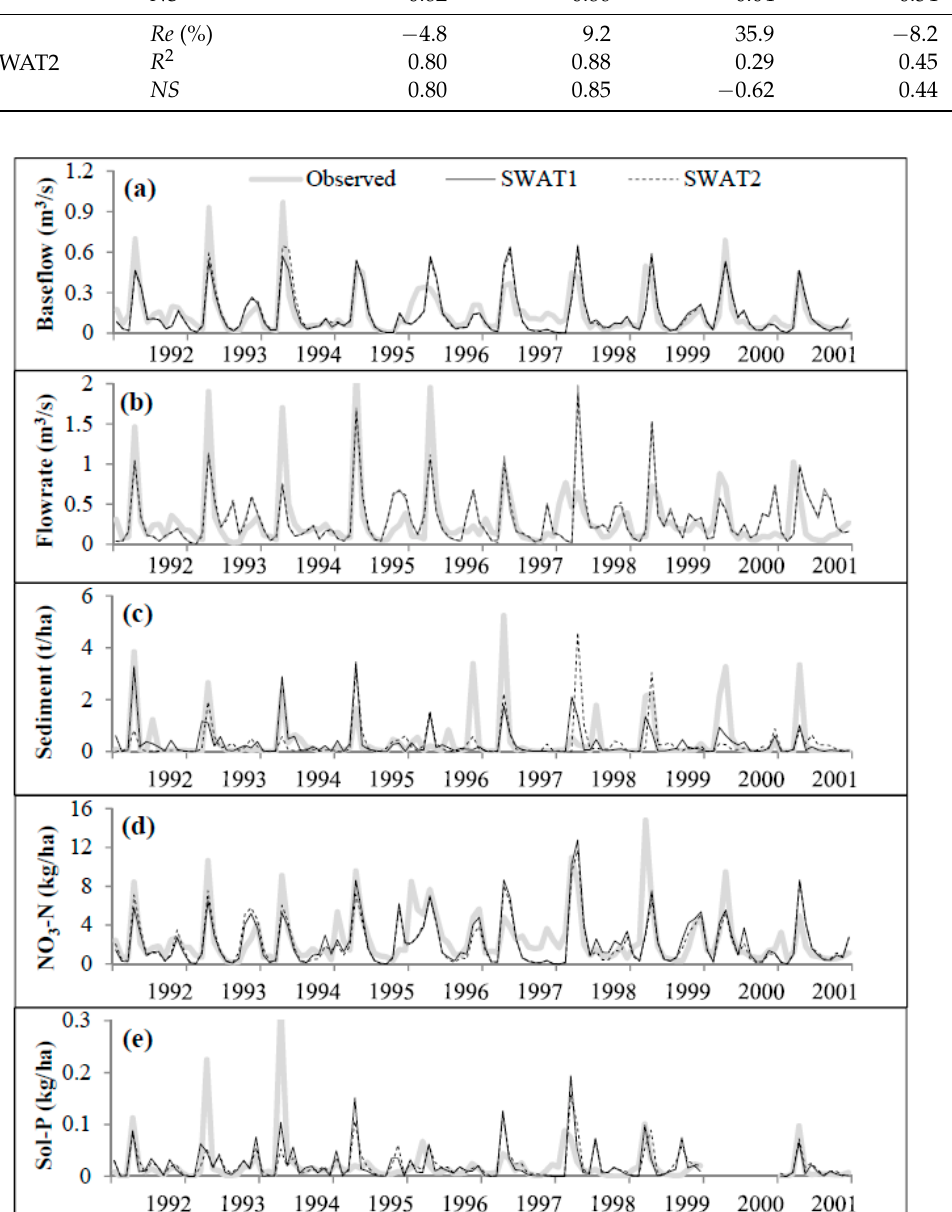
Figure 10. Comparisons of SWAT1- and SWAT2-simulated and observed monthly ( a ) baseflow, ( b ) flowrate, ( c ) sediment loading, ( d ) NO 3 -N loading, and ( e ) Sol-P loading for period Ι . The “observed” values of baseflow were calculated using the RDF method.